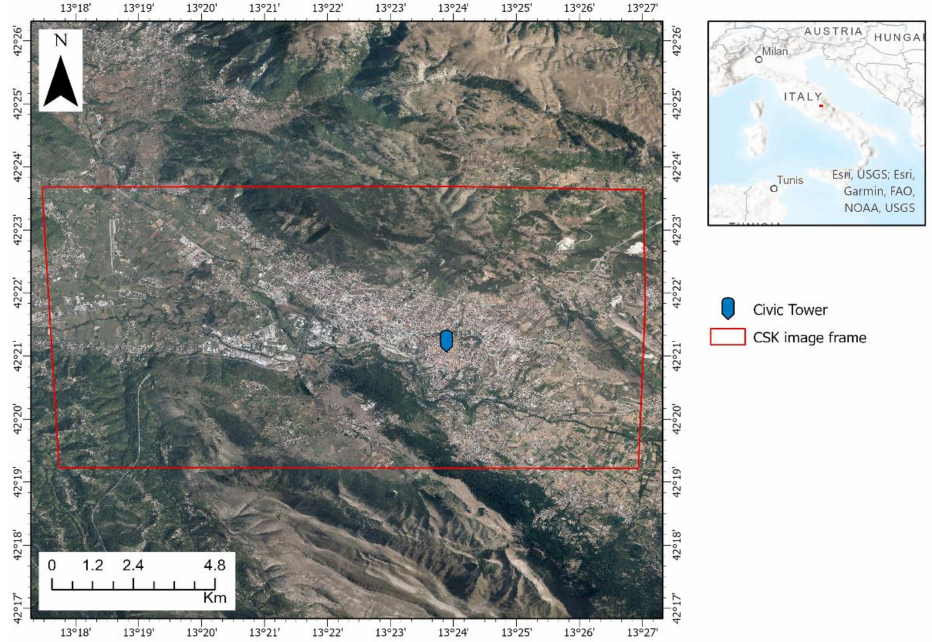
Figure 2. Location of the study